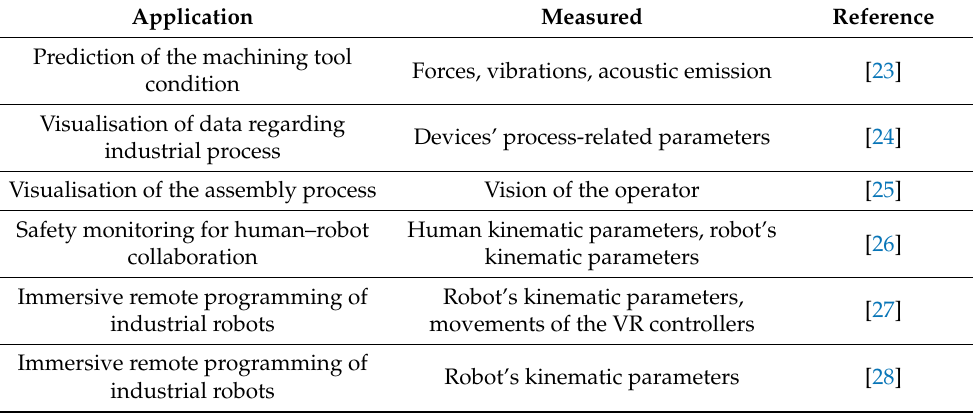
Table 2. Review of applications of virtual twins related to automation and robotics.